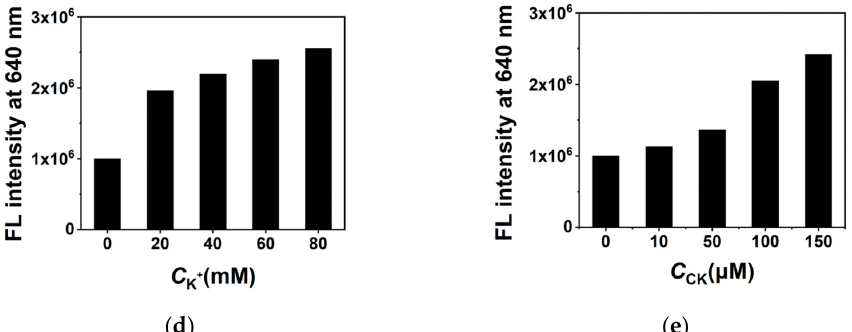
Figure 5. ( a ) The schematic demonstration of DNA-AgNCs synthesis and the sensing system for G4s. ( b ) The fluorescence spectra of 1000 nM c-myc-c DNA-AgNCs in the presence of different concentration of c-myc. ( c ) The linear relationship between target concentration and fluorescence intensity. ( d ) The histogram of fluorescence intensities in different concentrations of K + . ( e ) The histogram of fluorescence intensities in different concentrations of CK.